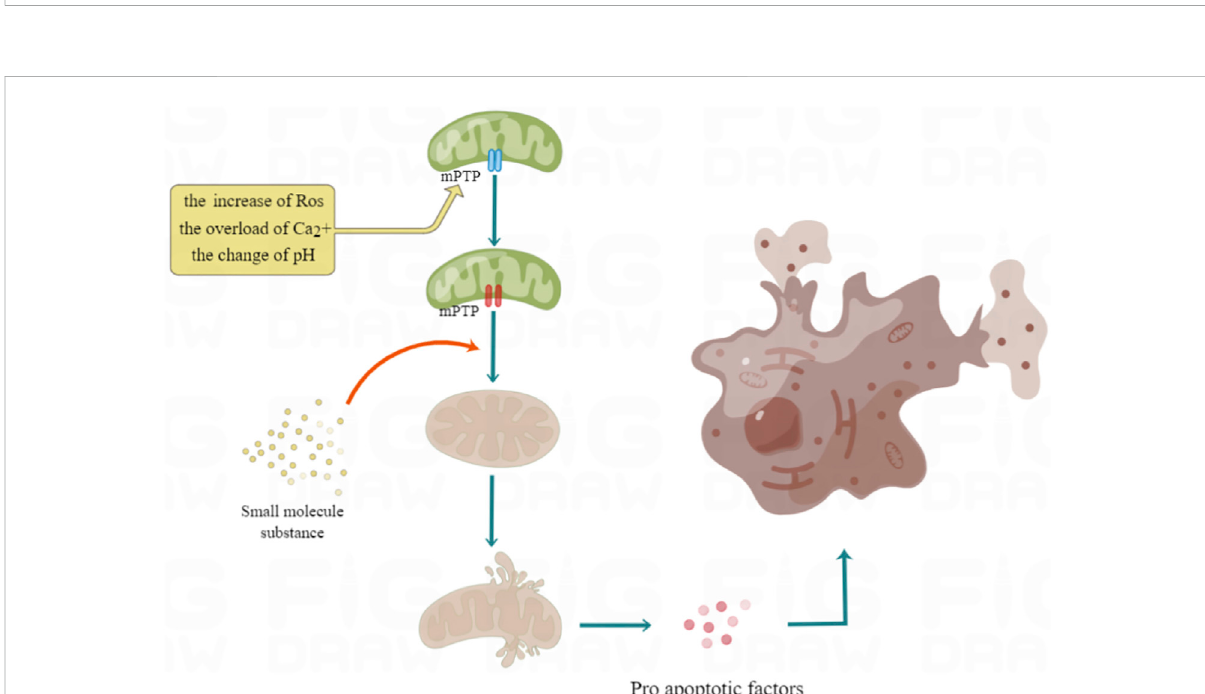
FIGURE 2 Mechanism ofexcessive opening ofmPTP leading to celldeath. TheoverloadofCa2+, ROS increase and pHchange will all leadto theopening of mPTP. These factors can prolong the opening time of mPTP by activating the important component of mPTP, Cyp D, so as to make the electrochemical proton gradient collapse, dissolve coupling with oxidized phosphoric acid, stop ATP synthesis, and then cause cell